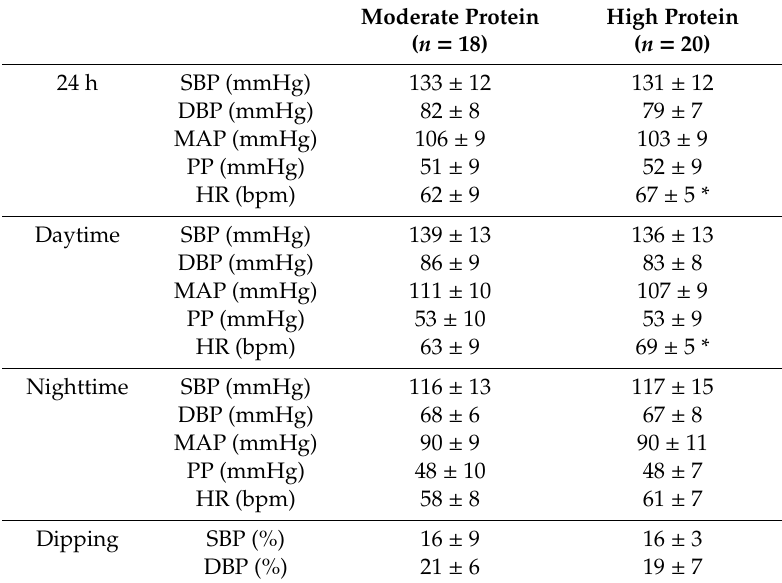
Table 1. Ambulatory blood pressure measurements during 48 h of the respiration chamber stay with a moderate- or high-protein dietary diet.